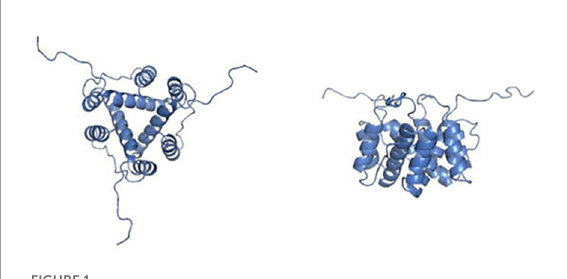
FIGURE1 Pictures depicting the secondary, tertiary, and quaternary structures of leukocyte differentiation antigen 74 (CD74). The picture on the left shows the structural view from the top. The right picture shows a side view of the same homotrimer. Pictures adopted from Meza-Romero et al. with permission (No. 5392361035630)